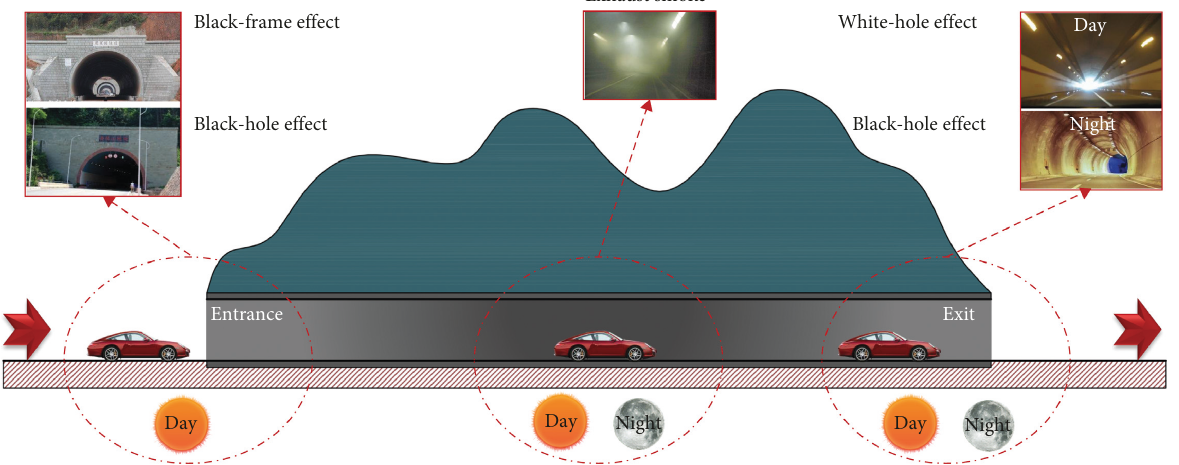
Figure 8: Visual problems induced by driving in the